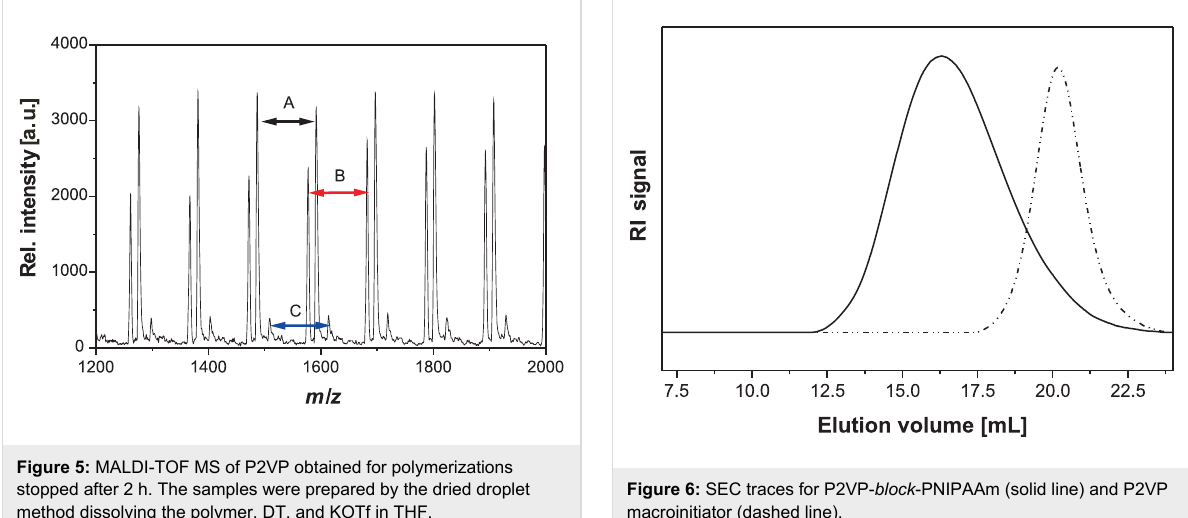
Figure 6: SEC traces for P2VP- block -PNIPAAm (solid line) and P2VP macroinitiator (dashed